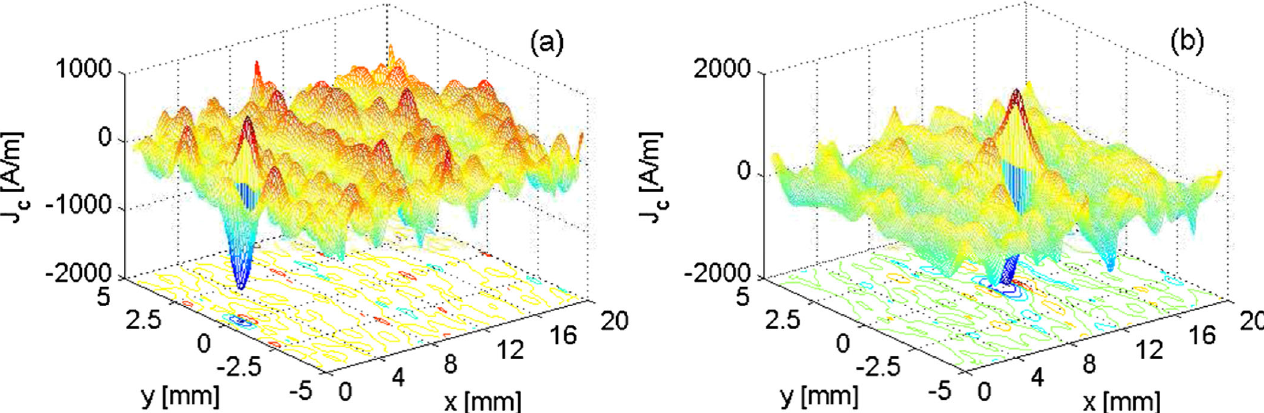
FIG. 4. (Color) Surface current J vs the grating width and length when the 50 pC bunch is at y ¼ 0 and x ¼ 0 : 75 mm (a), and c x ¼ 11 mm